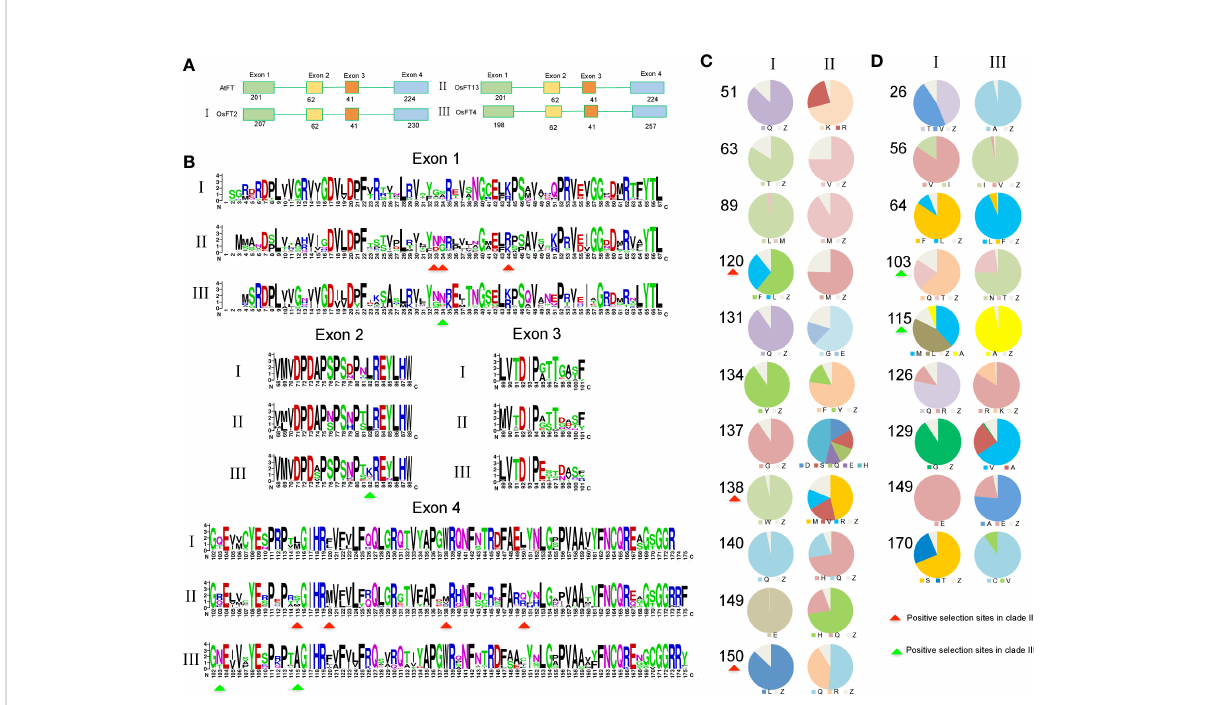
FIGURE 5 Characterization of sequences in three FT clades. (A) Exon and intron structures among three FT clades. (B) Logos representing motifs conserved within three clades. (C) Frequency of candidate amino acid residues responsible for function divergence between clade I vs. II. (D) Frequency of candidate amino acid residues responsible for function divergence between I vs. III. Red arrows represent positive selection sites in clade II, and green arrows represent positive selection sites in clade